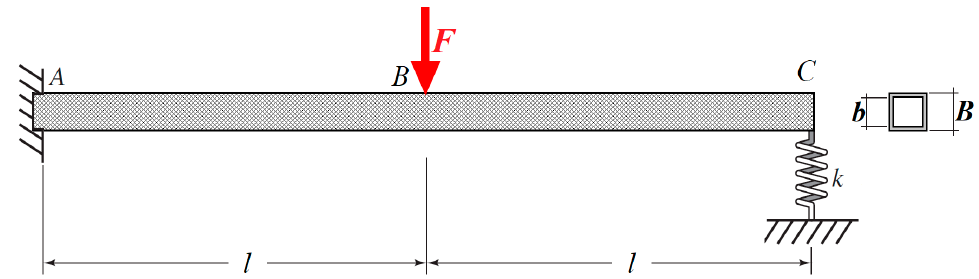
Figure 4. Numerical example 1—mechanical system.